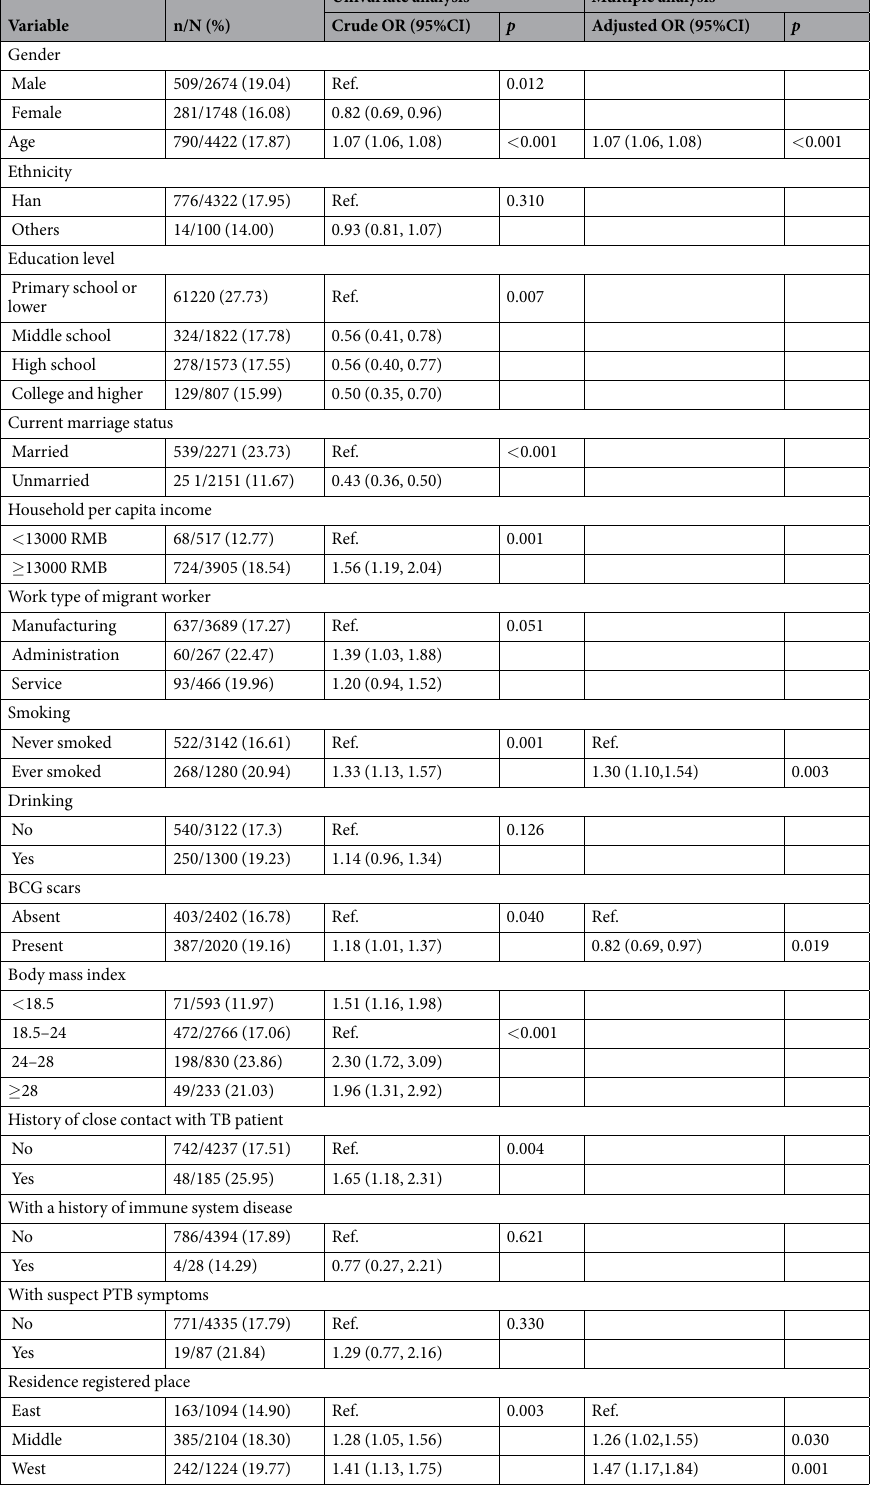
Table 3. Potential risk factors associated with QFT positivity. Abbreviation: BCG = Bacillus Calmette-Guerin. TB = Tuberculosis. QFT = QuantiFERON-TB Gold In-Tube. OR = odds ratio. CI = Confidence